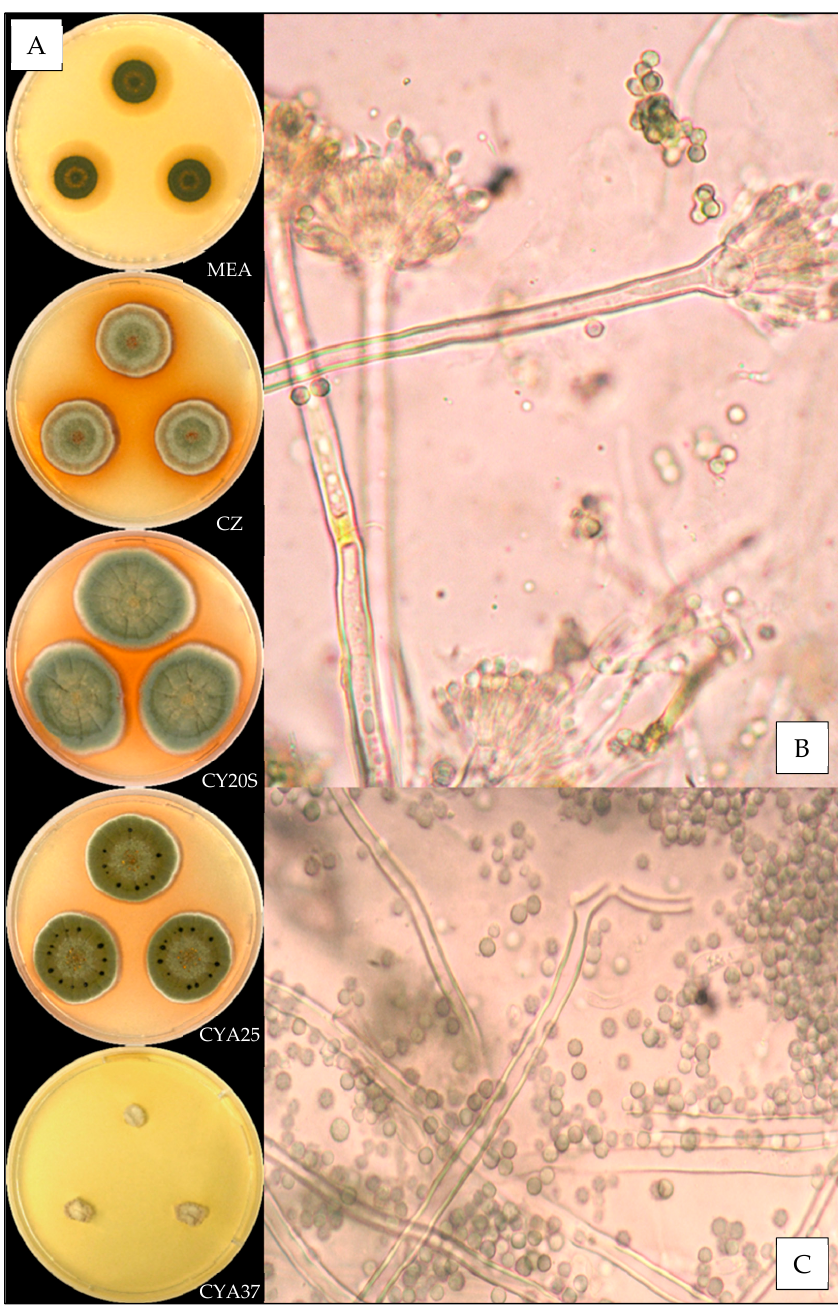
Figure 7. Aspergillus puulaauensis : ( A ) from top to bottom, colonies on MEA, CZ, CY20S, CYA25 and CYA37, 14 days. ( B ) Conidial head and ( C ) conidia (1000×). On MEA, there were circular and flat colonies with an entire margin, conidia were dark blue (#353a40), mycelium was white, reverse uncolored, texture was velutinous to granular and there was no exudate; when present, soluble pigment was orange (#c5792a). On CZ, there were circular and flat colonies with an entire margin, conidia were blue green (#404a45), mycelium was white, reverse brown (#463b2a), and texture was granular; when present, exudate was yellowish to brownish red (#cdac3f to #732f00), and when present, soluble pigment was dull yellow to dull orange (#e5c069 to #c08c35). On CY20S, circular and flat or colonies sometimes radially sulcate with an entire margin, conidia were greyish blue (#5f6a65), mycelium was white, reverse brownish orange (#975f04), and texture velutinous; when present, exudate was black (#12110c), and when